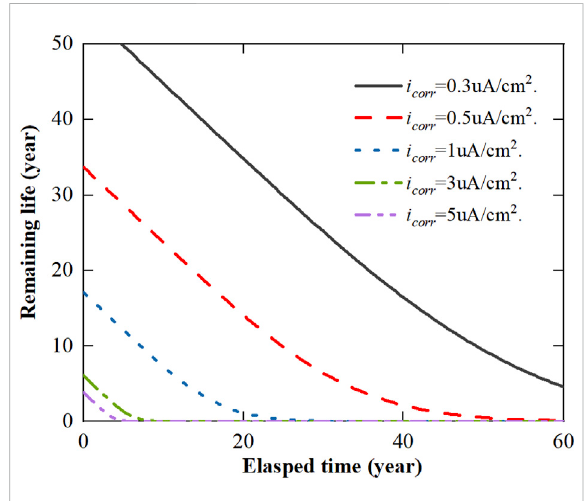
FIGURE 8 Predicted remaining useful life over time due to corrosion- induced concrete cracking with various corrosion rates.